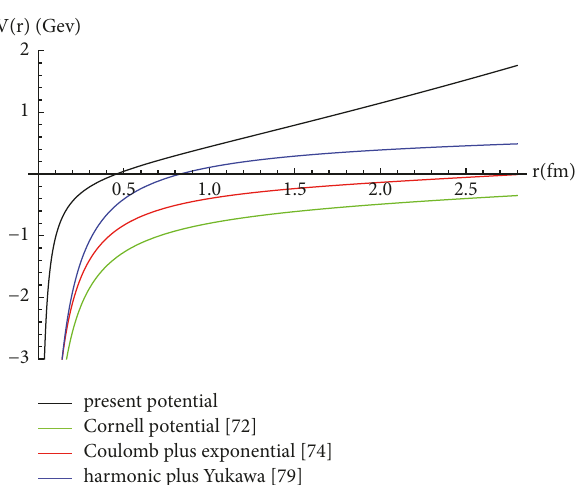
Figure 1: The current potential and other potential models are plotted as functions of distance r .